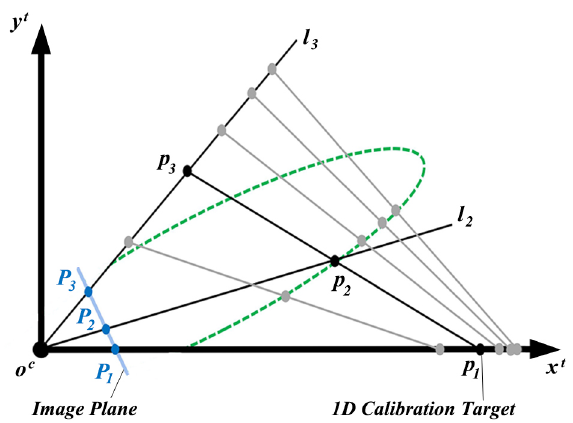
Figure 2. 2D local coordinate system on the 2D plane spanned by the camera optical center and the 1D